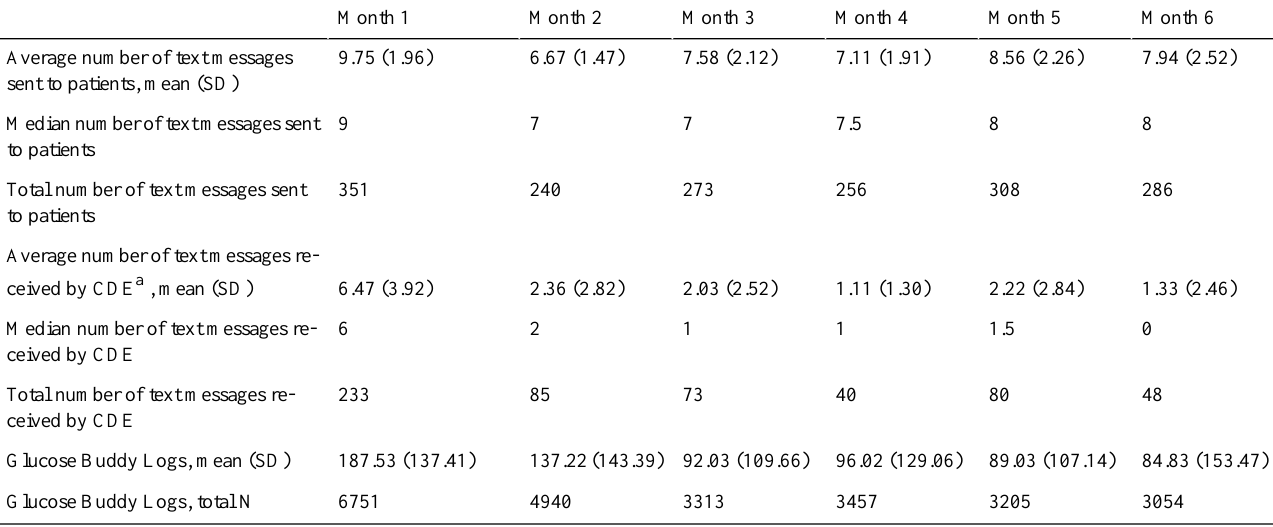
Table 3. Engagement with